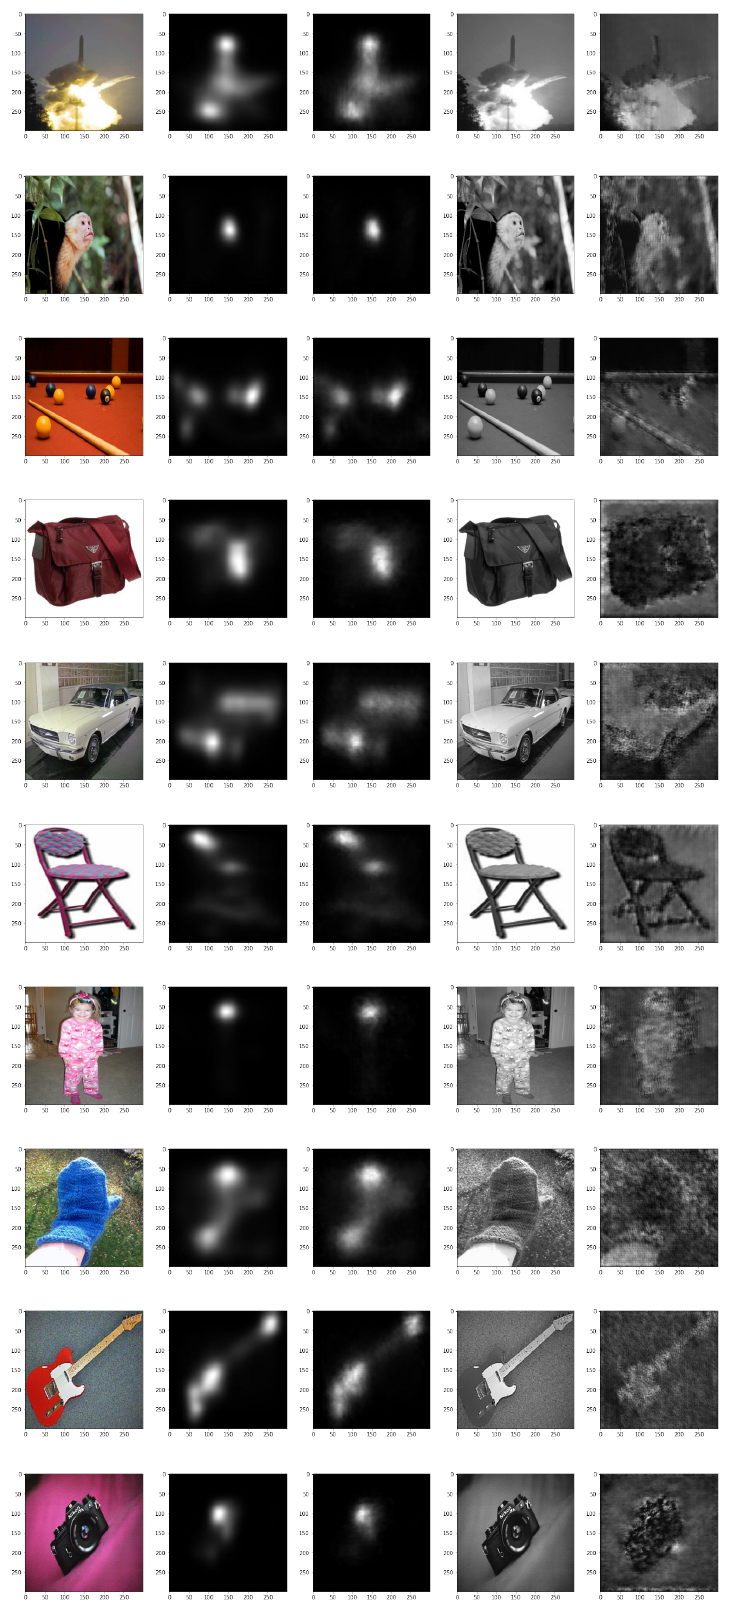
Figure 18. Reconstructed saliency and gray-scale images for categories 21–30; from ( left ) to ( right ): image used as stimulation, fixation map, EEG-based reconstructed saliency map, gray-scale image, EEG-based reconstructed gray-scale